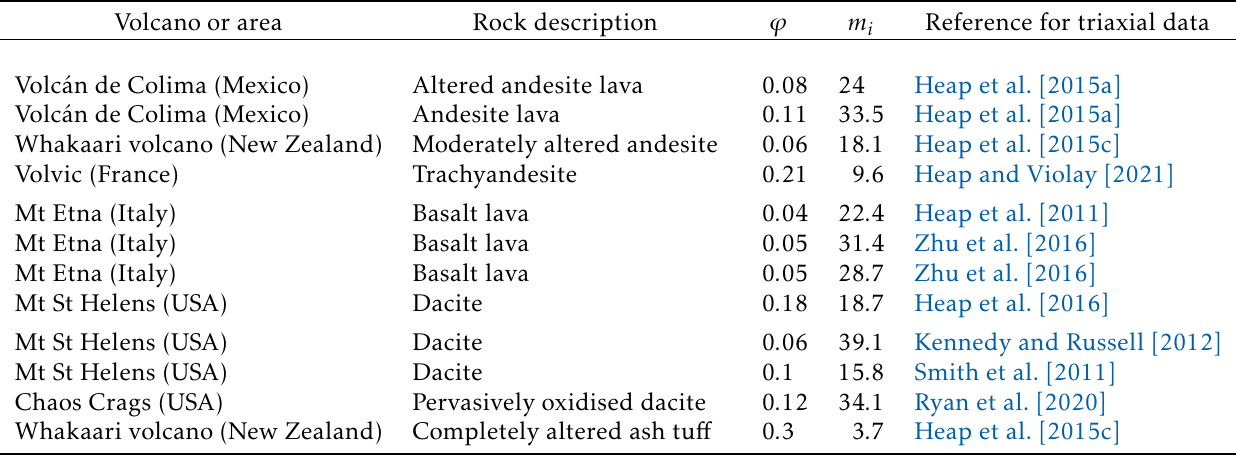
Table 2: Derived dimensionless Hoek-Brown constant m i for a range of volcanic rocks and textures (andesite, basalt, dacite, and tuff), calculated from published triaxial data, where ϕ is the average connected porosity. Each derived value is based on test results from 3–5 individual samples in the source publications. Alteration and primary texture are given, if provided in the source literature.